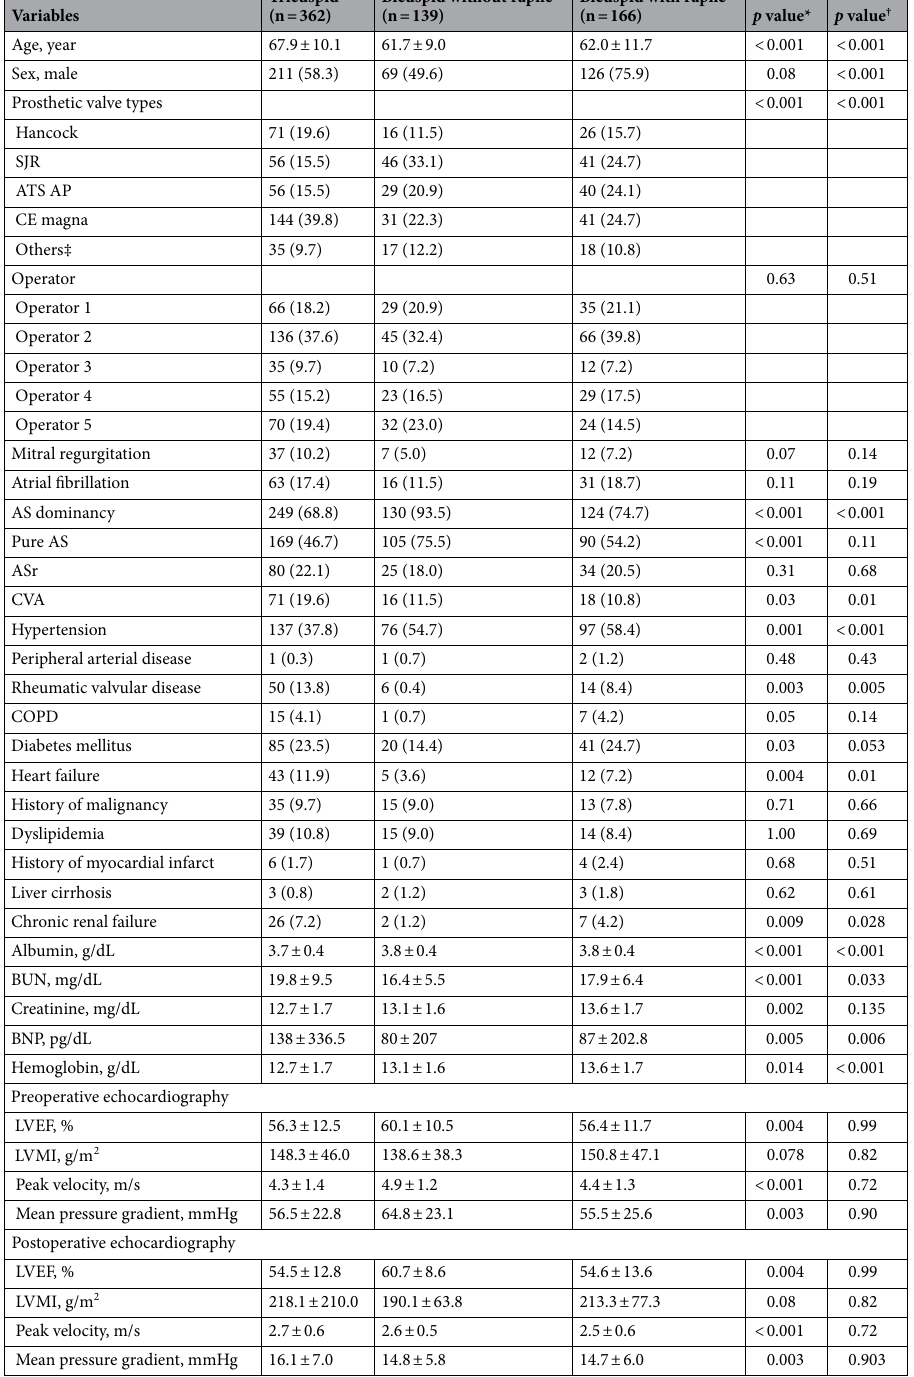
Table 1. Clinical characteristics and echocardiographic findings. Data are shown as the number of patients with percentages in parentheses or mean ± standard deviation. AS, aortic stenosis; ASr, aortic stenosis and minimal to mild aortic regurgitation; BNP, brain natriuretic peptide; BUN, blood urea nitrogen; CE magna, Carpentier-Edwards PERIMOUNT Magna; COPD, chronic obstructive pulmonary diseases; CVA, cerebrovascular accident; LVEF, left ventricular ejection fraction; LVMI, left ventricular mass index; SJR, St Jude Medical Regent. * p values are obtained by comparing between tricuspid and bicuspid without raphe and † between tricuspid and bicuspid with raphe. ‡ Valves including Sorin (n = 24), On-X (n = 12), CM TopHat (n = 11), Trifecta (n = 11), Mitroflow (n = 8), Mosaic (n = 3) and Biocor (n =